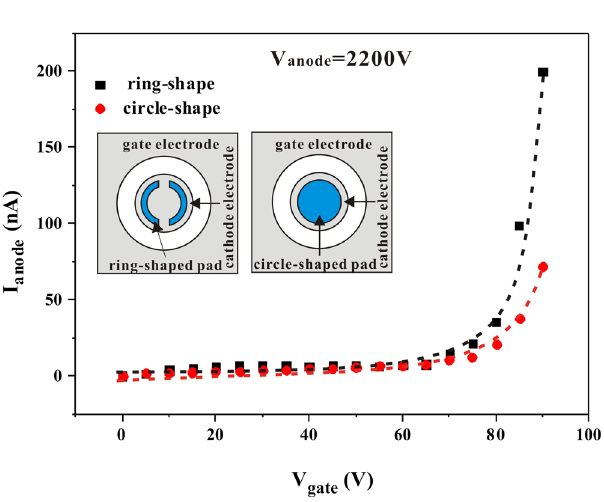
Figure 7. Comparison of the field emission characteristics of coplanar-gate FEAs with ring-shaped ZnO nanowire pads and circle-shaped ZnO nanowire